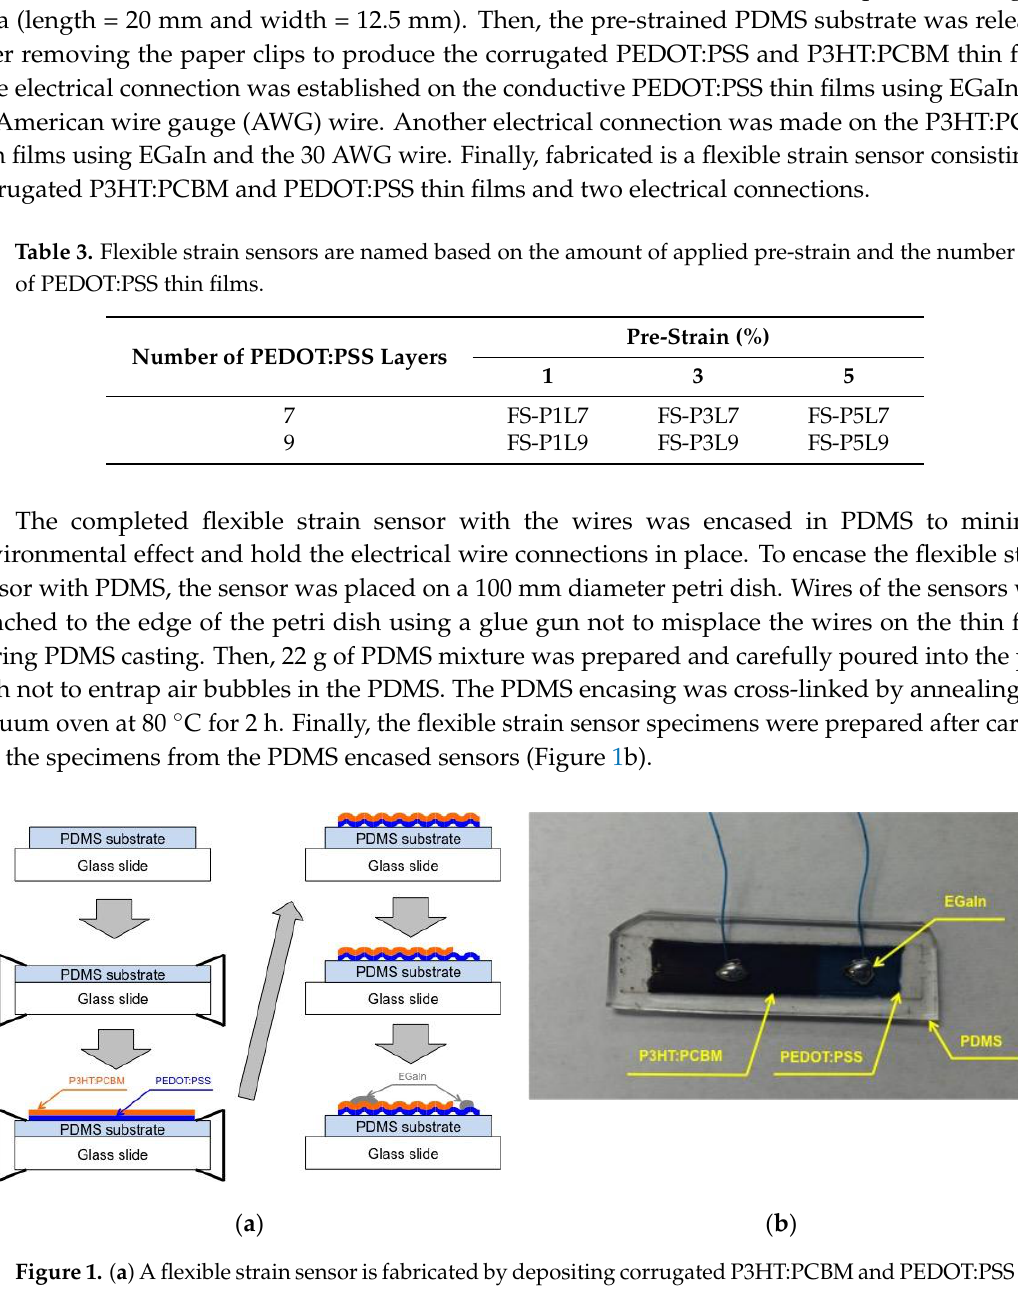
Table 3. Flexible strain sensors are named based on the amount of applied pre-strain and the number of PEDOT:PSS thin films. Number of PEDOT:PSS Layers